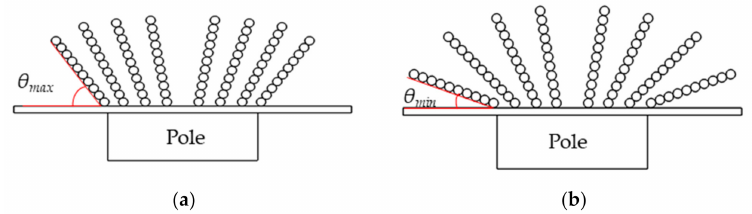
Figure 4. Schematic diagram of magnetic cluster fluctuation. ( a ) The highest position; ( b ) The lowest